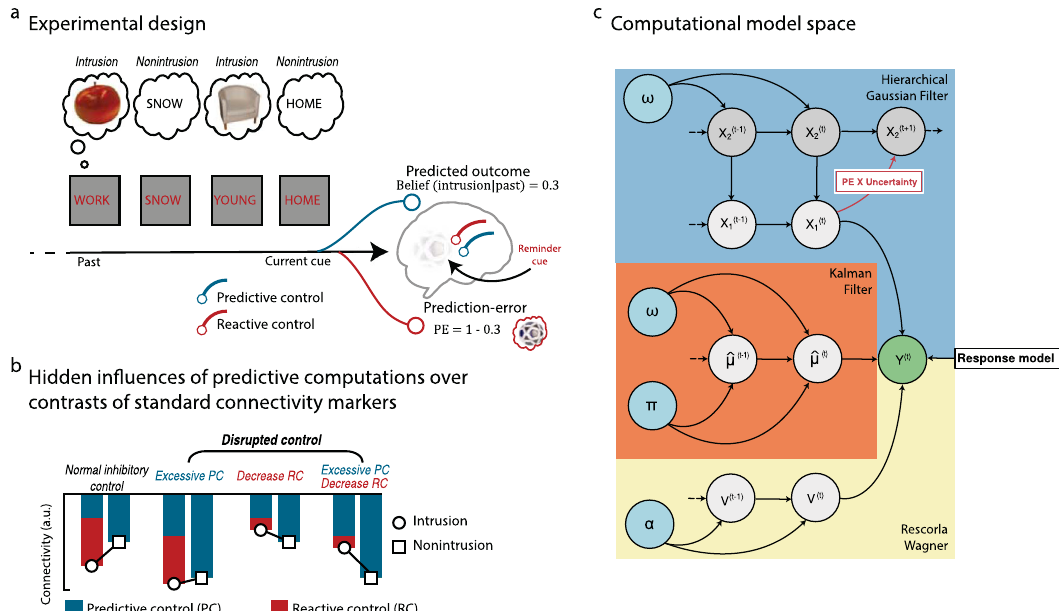
Fig. 1 Design and computational models. a After learning word – object pairs, participants performed a memory suppression task in which they were asked to prevent the memory of the images associated with the cue words from entering awareness. They then rated the presence or absence of intrusive memories during suppression attempts. The estimation that an upcoming cue will trigger an intrusive memory (i.e., belief) can be inferred from previous encounters, providing an adaptive advantage in the form of the deployment of optimum memory control and proactive prevention of memory retrieval (i.e., predictive control ). Reactive control is engaged when intrusive memories unexpectedly cross the proactive gate, resulting in a prediction error (PE) that triggers additional inhibition and updating of future expectations. It should be noted that recall cues (i.e., think items) are not displayed here (see the “ Methods ” section). The apple and the chair items are selected from the Bank Of Standardized Stimuli (BOSS) and published under CC BY SA license (https://creativecommons.org/licenses/by-sa/3.0/) 55 . b Toy example. Standard contrast analyses of intrusive and nonintrusive cues cannot identify the contribution of these critical computational quantities on the disruption of the connectivity markers of inhibitory control. c Computational model space. Binary intrusion ratings across the suppression task were fed into computational models to track belief formation across the suppression task. In the two- level hierarchical Gaussian fi lter (HGF; pale blue panel), beliefs are hierarchical and dynamically weighted by uncertainty. The perceptual parameter ω regulates the speed of belief adjustment throughout the task. The Kalman fi lter (KF; pale orange) also includes dynamic belief updating, which is regulated by two free perceptual parameters, π and ω , encoding belief reliability and uncertainty, but it does not assume hierarchical beliefs. The Rescorla – Wagner model (RW; pale yellow) is a simpler non-hierarchical model with a fi xed, participant-speci fi c learning rate α . The response model describes the log- probability of the behavioral outcomes (i.e., intrusion or nonintrusion rating) given beliefs through a beta density function. These trial-wise log-probabilities are used to compute model